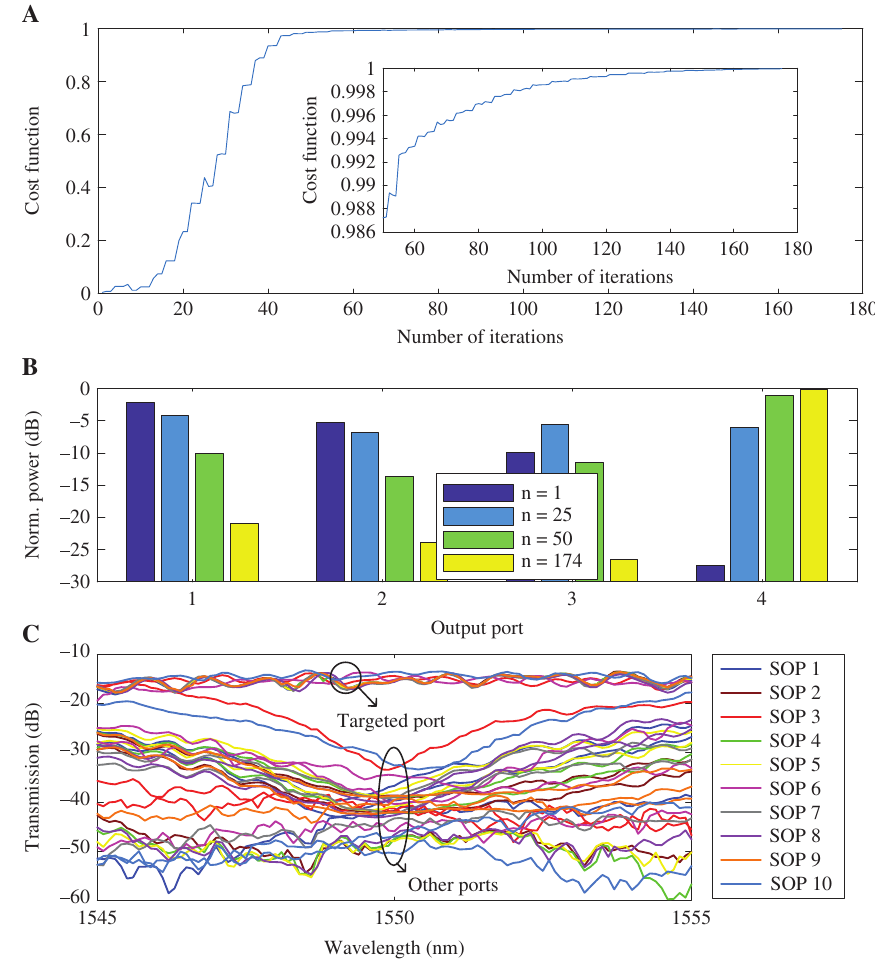
Figure 5: Experimental results for polarization controller. (A) Cost function dependent on the number of iterations (Video S2). (B) Light power distributions when the number of iterations equals 1, 25, 50, and 174. (C) Transmission spectra (including the TE grating couplers) for 10 cases with random SOPs and random targeted